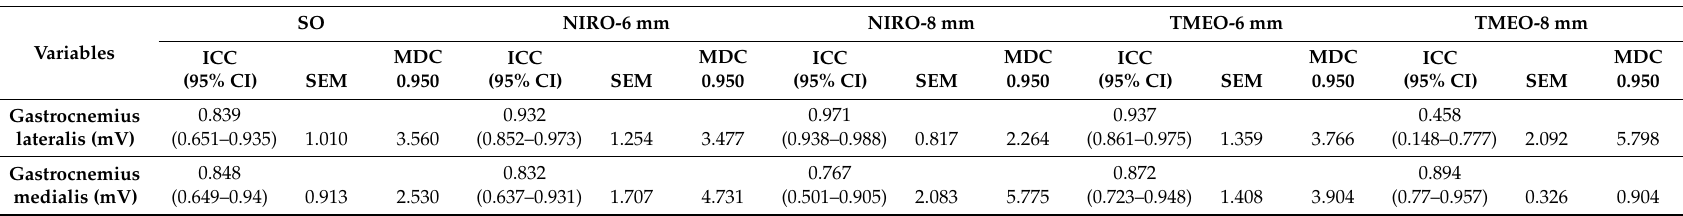
Table 2. Reliability ICC of variables with “shoe only” versus 6- and 8-mm of novel inverted rocker orthoses (NIRO) and traditional Morton extension orthoses (TMEO).